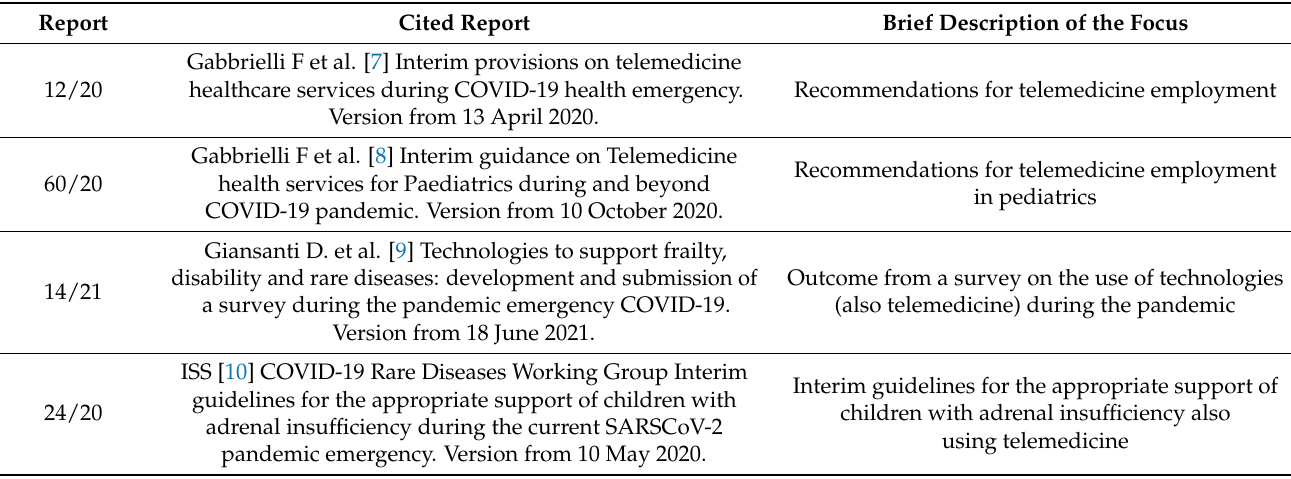
Table 3. ISS reports dealing with the